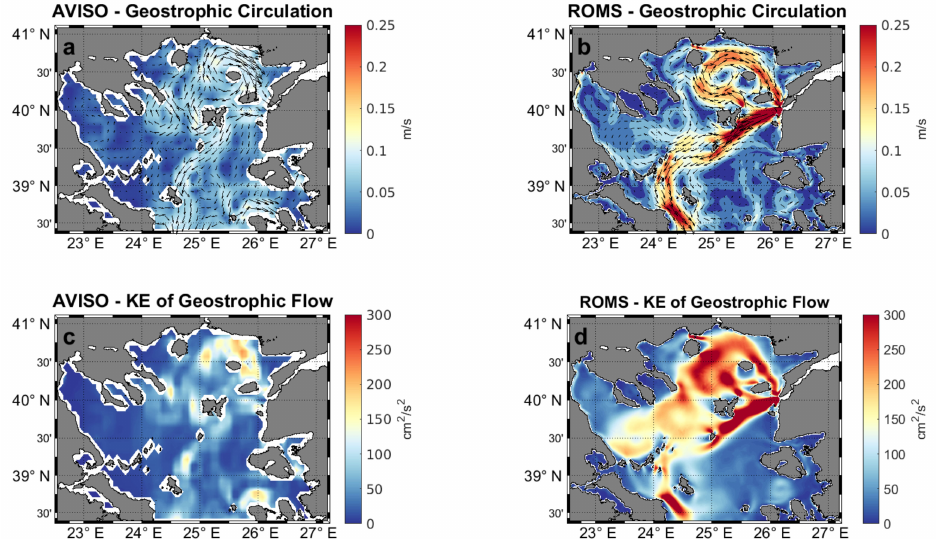
Figure 16. North Aegean mean geostrophic circulation and geostrophic kinetic energy (GKE) from 1993 to 2013. Panels ( a , c ) are derived from satellite data. Panels ( b , d ) are the estimations from model